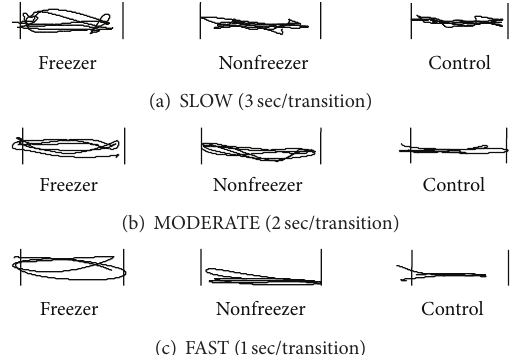
Figure4:COGpatternduringmediolateralRWS.Eachgraphshows a representative COG movement pattern for a freezer, nonfreezer, and control participants. The vertical bars indicate the distance of the shift the participants were instructed to make and are set at 50% of the participants’ limit of stability. Panels (a), (b), and (c) show the COG pattern when a cue was given with respectively a 3 second, 2 second, and 1 second